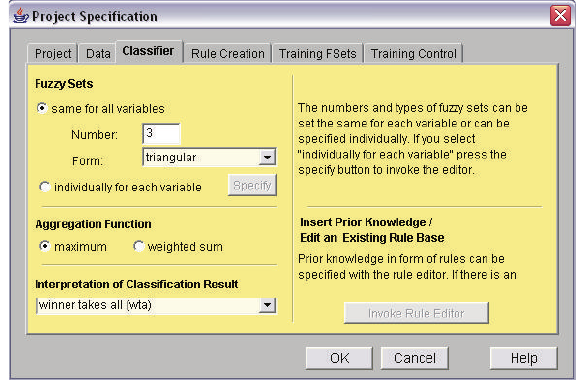
Figure 6: New Project’s Training FSets tab.